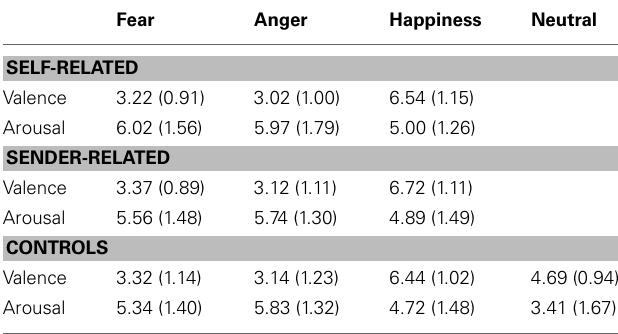
Table 3 | Experiment 2: rating data of emotional faces for the faces that were preceded by self-related pronoun-noun pairs, sender-related pronoun-noun pairs, or no pronoun-noun pairs (control